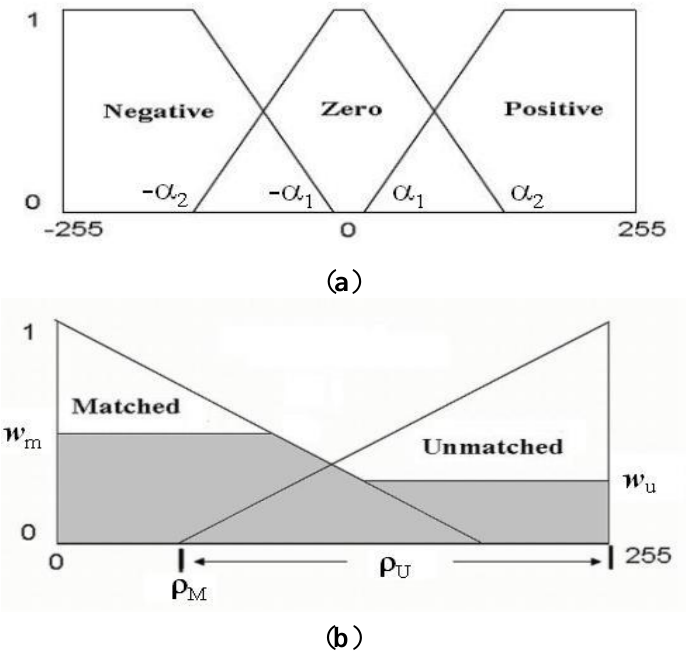
Figure 10. Membership functions for color image segmentation. ( a ) Membership functions for color differences; ( b ) Membership functions for